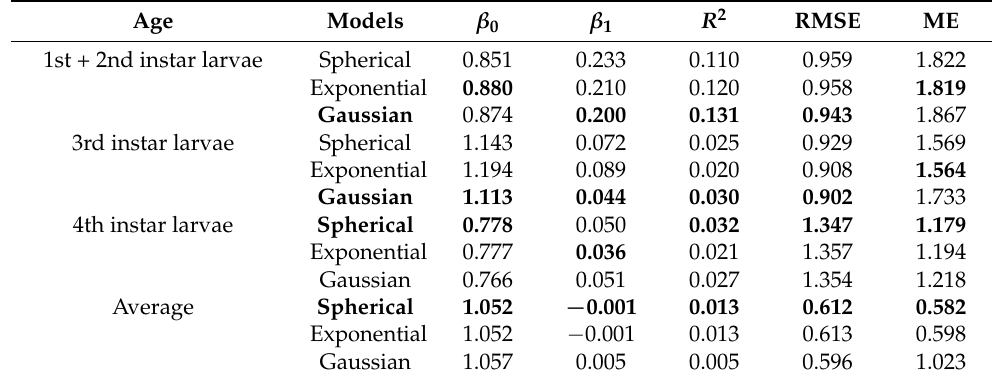
Table 2. Results of cross-validation of the semi-variogram models (spherical, exponential, and